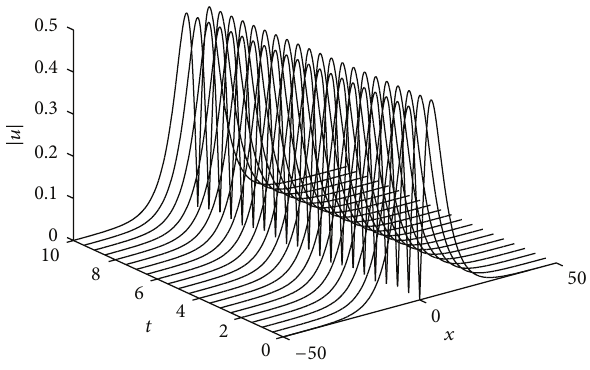
Figure5: Theevolution ofthenumerical solution of |𝑢| with 𝜖 = 8.0 .